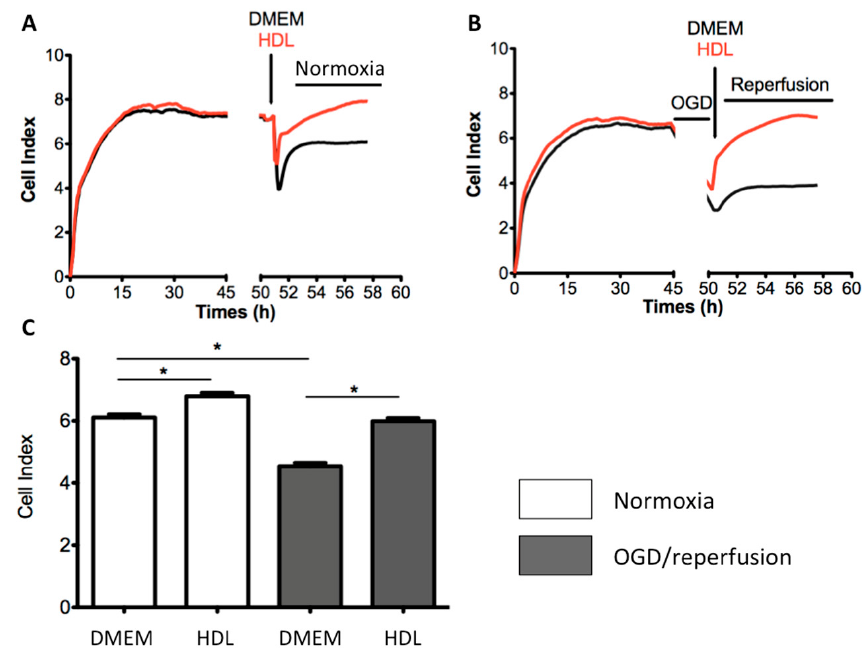
Figure 4. Role of HDLs on the integrity of a human cellular model of BBB in normoxic and is- chemia/reperfusion con-ditions. Cell impedance (converted into cell index) was monitored in real time, and plots were produced using the RTCA Software. ( A , B ). At confluence, hCMEC/D3 were subjected to normoxia or to a 4 h oxygen-glucose deprivation (OGD) followed by reperfu- sion. ( C ) Cell index values were compared 4 h after incubation with or without HDLs in nor- moxia and OGD/reperfusion conditions. HDLs restored endothelial integrity in normoxic and OGD/reperfusion conditions compared to DMEM alone (* p <